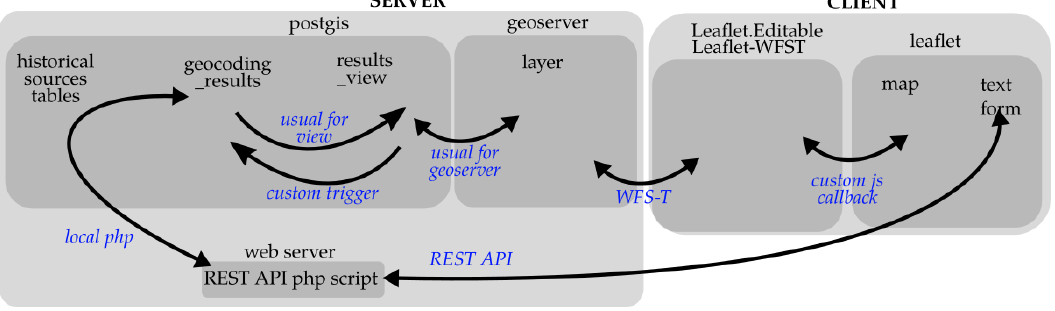
Figure 7. Conceptual architecture for interactive display and edit of geocoding results. The stack contains only standard components. The use of WFS-T and REST standard protocols makes the change or customisation of some components